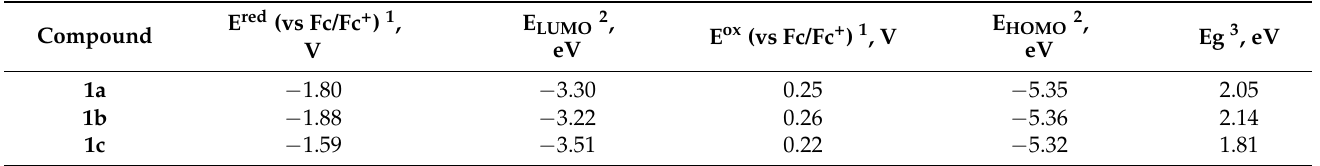
Table 2. Electrochemical properties of the dyes 1 ( a – c ) in DMF